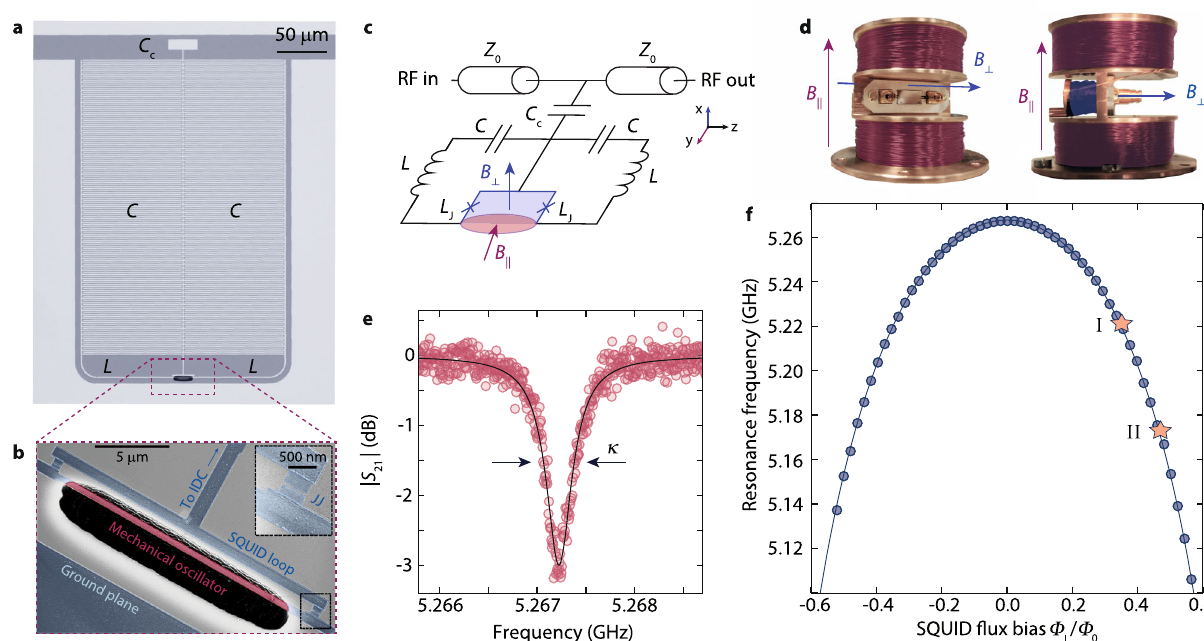
Fig. 1 A superconducting quantum-interference cavity parametrically coupled to a mechanical nanobeam. a Optical micrograph of the circuit. Bright parts are aluminum, dark parts are silicon substrate. The LC circuit combines two interdigitated capacitors (IDCs) C with two linear inductors L , connected through a superconducting quantum-interference device (SQUID) with total Josephson inductance L S = L J /2. The circuit is capacitively coupled to a Z 0 = 50 Ω coplanar waveguide feedline (top of image) with a coupling capacitor C c and surrounded by ground plane. b Scanning electron micrograph of the constriction-type SQUID, showing the two Josephson junctions and the mechanical oscillator as part of the loop released from the substrate. The inset shows a zoom-in to one of the nanobridge Josephson junctions. c Circuit equivalent of the device. For the experiments, two magnetic fi elds can be applied. The fi eld B ⊥ is oriented perpendicular to the chip plane and is used to set the fl ux-bias working point of the SQUID Φ ⊥ . The parallel fi eld B ∥ transduces mechanical displacement of the out-of-plane mode to additional fl ux Φ ∥ = B ∥ l δ x threading the SQUID loop. d shows the sample integrated into a printed- circuit board with two microwave connectors and mounted into a 2D vector magnet. The large split coil is used to generate B ∥ , a small single coil behind the chip generates B ⊥ . e Transmission response ∣ S 21 ∣ of the cavity at B ∥ = 25 mT and B ⊥ = 0. From a fi t to the data, we extract the resonance frequency ω = 2 π ⋅ 5.2673 GHz, the total linewidth κ = 2 π ⋅ 380 kHz, and the external linewidth κ = 2 π ⋅ 110 kHz. Data are shown as circles, fi t as black line. 0 e f Resonance frequency ω 0 vs magnetic fl ux Φ ⊥ , normalized to one- fl ux quantum Φ 0 at B ∥ = 25 mT. Circles are data, line is a fi t. The two operation